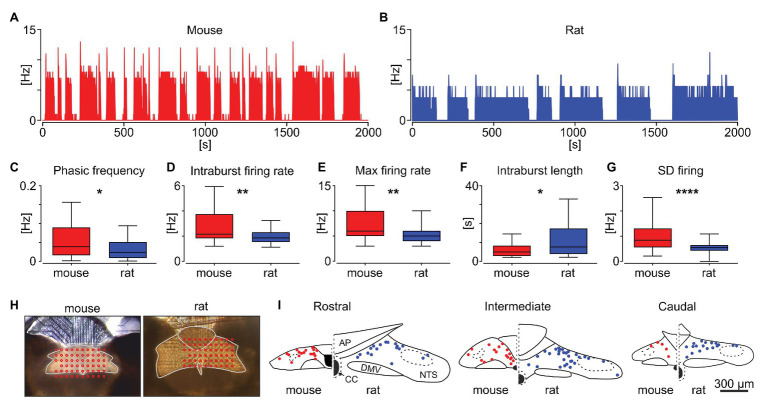
Comparison of phasic activity pattern in the mouse and rat NTS. Example phasic firing rate histograms (bin: 1 s) for mouse (A) and rat (B). (C–G) Statistical comparison of the frequency of phasic burst occurrence (phasic frequency), intraburst firing rate, maximum firing rate, intraburst length, and the variability of firing within the intraburst (shown as the SD of firing). The horizon line within the box is median value, while the box indicates interquartile range. Whiskers include all data points. *p < 0.05, **p < 0.01, ****p < 0.0001, Mann-Whitney tests. (H) Photographs of brainstem slices mounted on the multi-electrode array with the dorsal vagal complex outlined in grey and the location of recording electrodes shown in red. (I) Anatomical reconstruction of the recorded phasic cells in the mouse (in red) and rat NTS (in blue). AP – area postrema, CC – central canal, DMV – dorsal motor nucleus of the vagus.